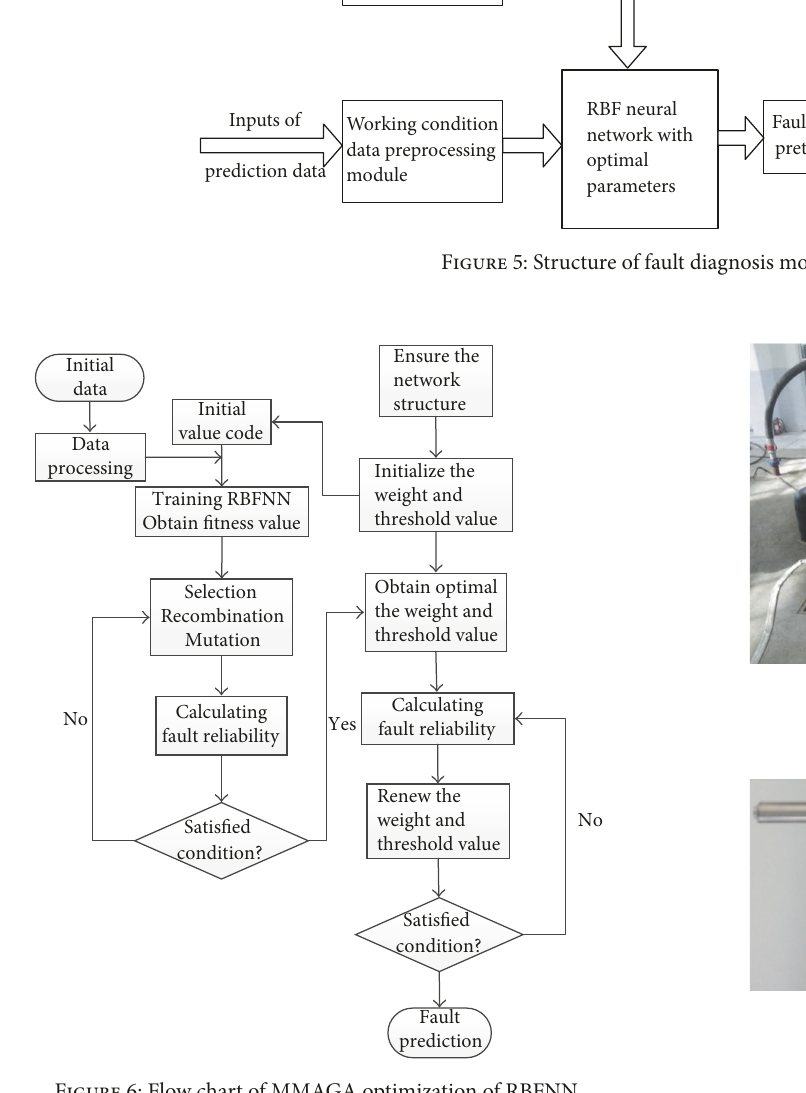
Figure 6: Flow chart of MMAGA optimization of RBFNN.